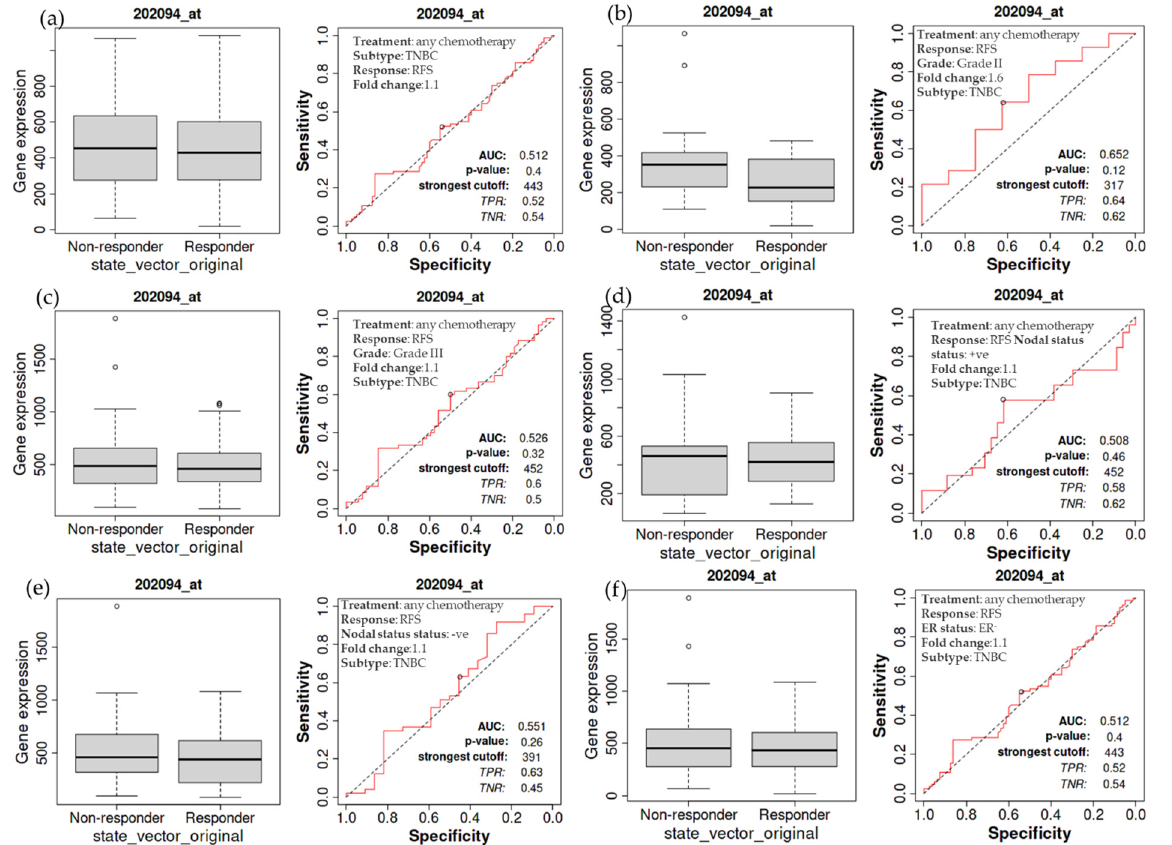
Figure 6. Relapse-free survival of patients with TNBC as a function of BIRC5 expression. Any chemotherapy-treated TNBC patients did not show a significant difference in BIRC5 expression, as shown by a non-significant difference in relapse-free survival ( a ). This also applies to TNBC patients with cancers of grade II ( b ), grade III ( c ), nodal positive ( d ), nodal negative ( e ), and estrogen negative ( f ) TNBC patients.